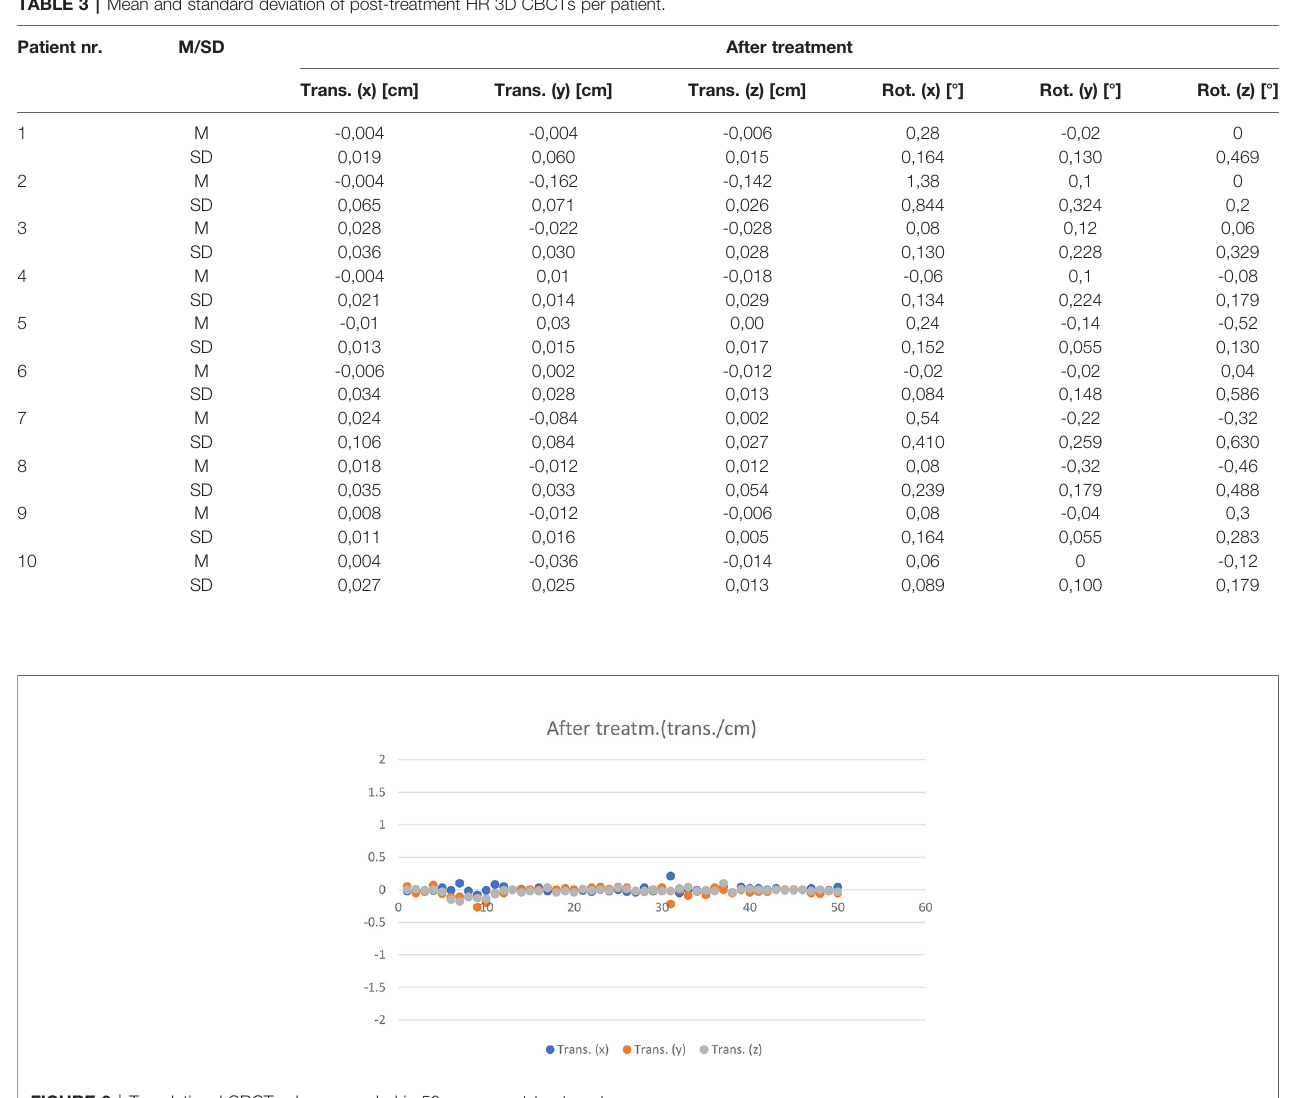
FIGURE 6 | Translational CBCT values recorded in 50 cases post-treatment.